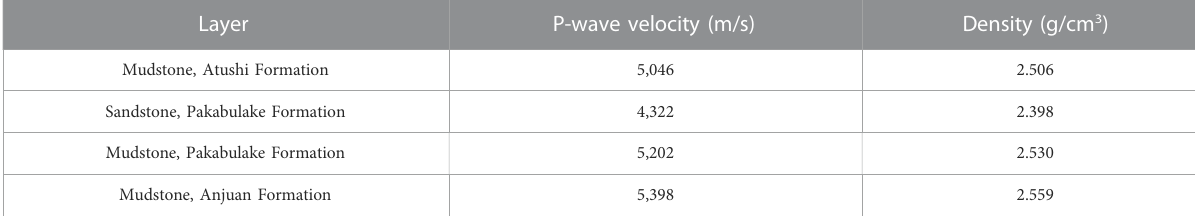
TABLE 1 Formation parameters of the reservoir geologic